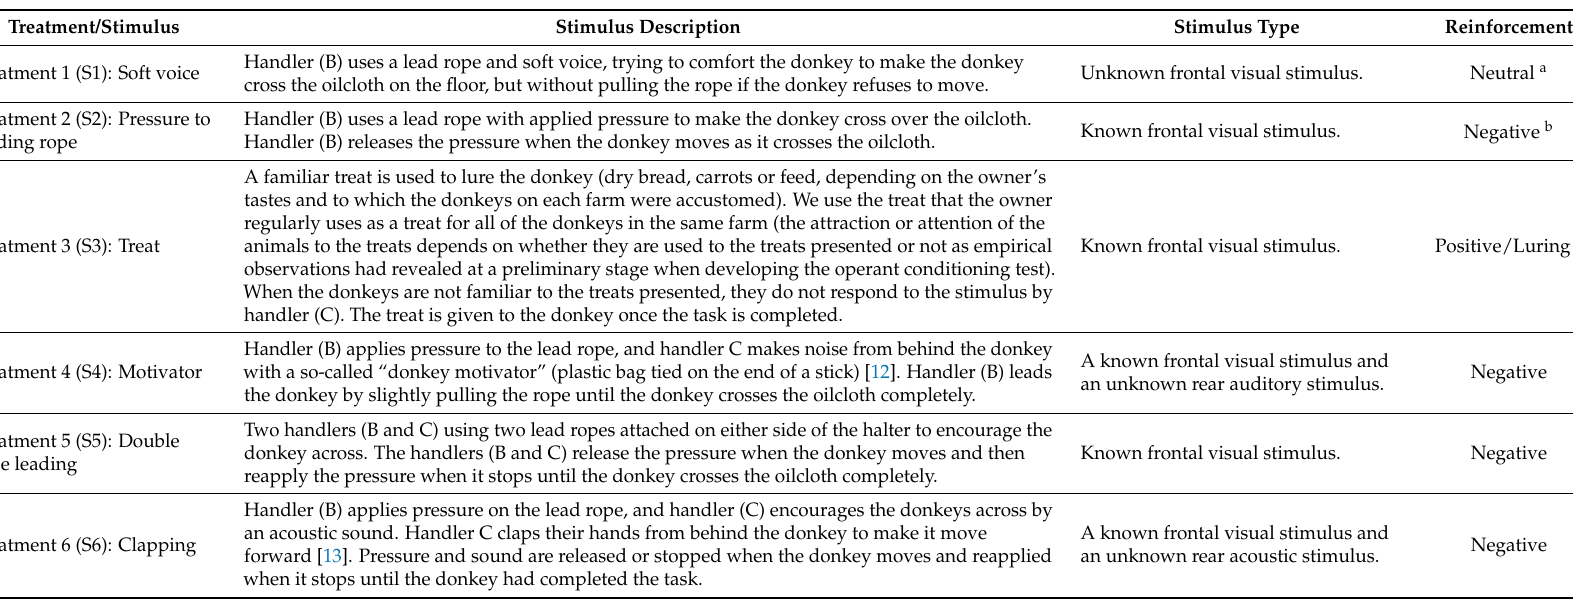
Table 2. Description of the treatments and stimuli presented, their reinforcement classification and terminology